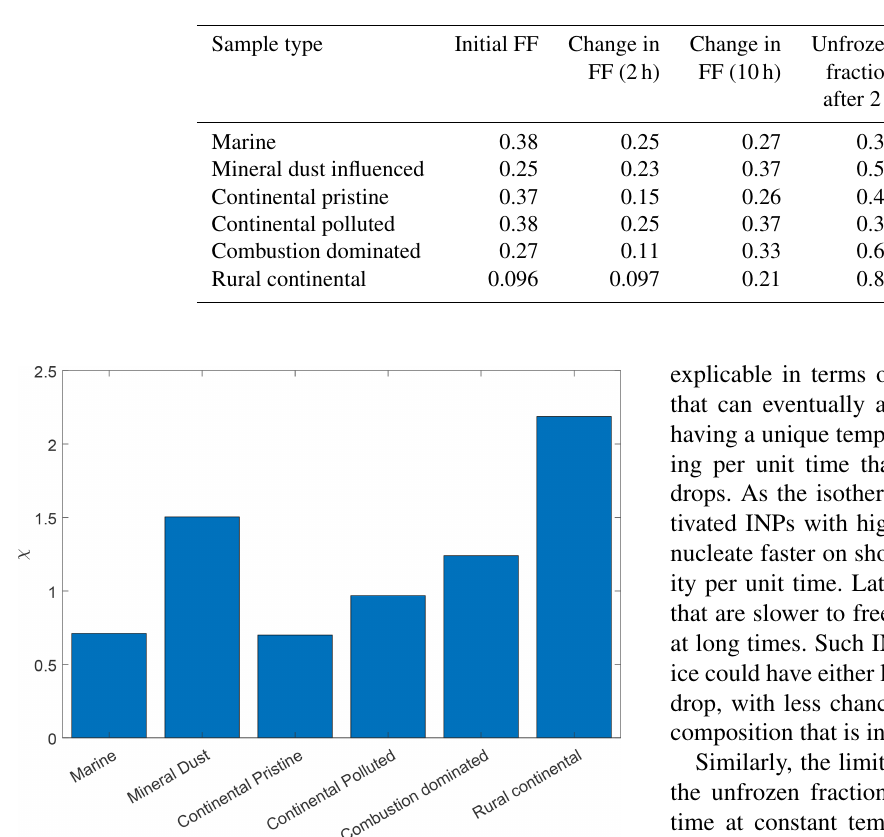
Table 3. The averaged initial ice fractions for the samples at t = 0 and the observed average increase in ice fraction after 2 and 10h isothermal time. The experimental data for the isothermal time between 2 and 10h of exposure to constant conditions are much scarcer than the data for the first 2h since so few drops freeze then. This can also be seen in Fig. 9. χ is the fractional increase in frozen fraction (FF) after 10h, also shown in Fig. 10.